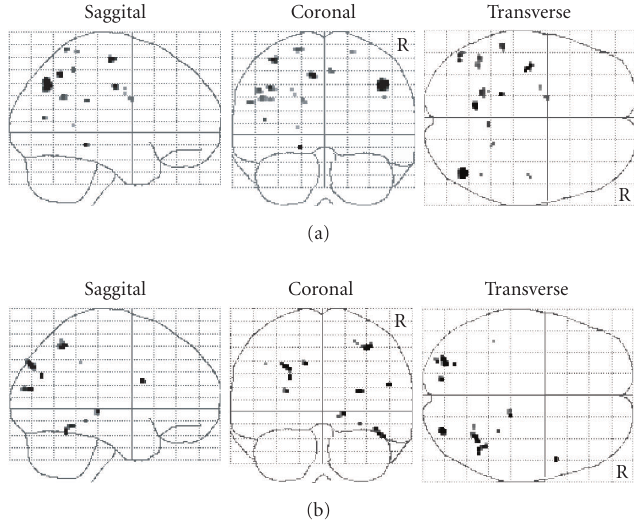
Figure 3: OrT pattern displayed in sagittal, coronal, and transverse projection views using SPM99 software. Voxels mapped have inverse coe ffi cient of variation (ICV) values that exceed an absolute threshold of 3 . 09. (a) Repetition augmentation—regions that increase in acti- vation with object repetition. (b) Repetition suppression—regions that decrease in activation with object repetition. (ICV values estimated using a bootstrap method. Anatomical designations for mapped voxel clusters are tabulated in Table